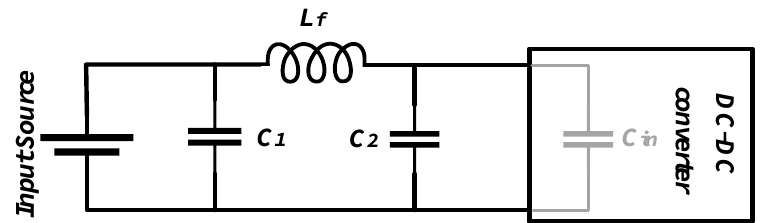
Figure 15. ( a ) Input source current and the current of the ( b ) switch and ( c ) diode D1 in the proposed boost converter.